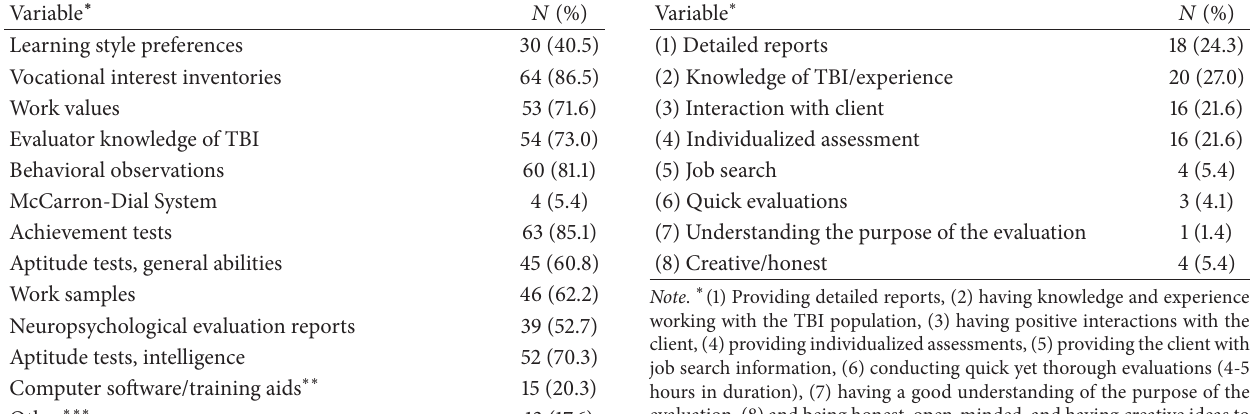
Table 4: Important characteristics of successful TBI vocational